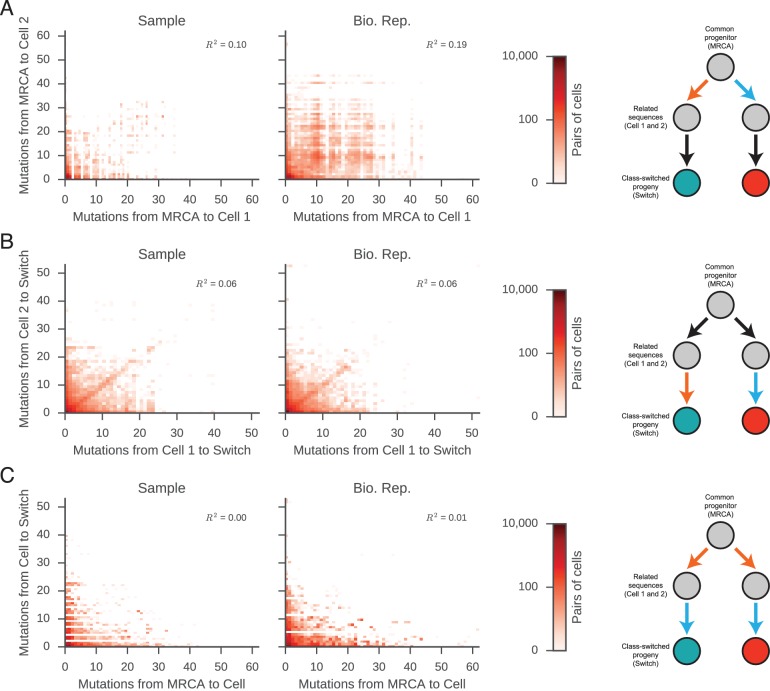
Mutational distances among related cells, common progenitors, and switched progeny are not correlated.Number of mutations from (A) common progenitor (most recent common ancestor [MRCA]) to cell 1 and cell 2, (B) cell 1 to switched progeny and cell 2 to switched progeny, and (C) common progenitor to cell and cell to switched progeny. The mutational distances compared in each panel are indicated by the colored edges in the motif on the right (x-axis, orange; y-axis, blue). Color indicates number of pairs of related sequences in each bin. Squared Pearson correlation values are shown.